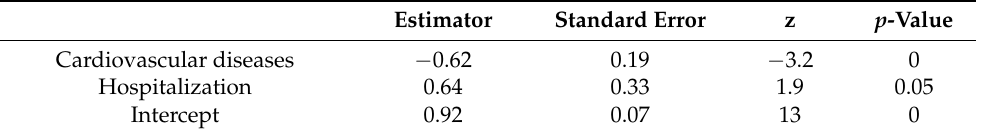
Table 3. Question five—logistic regression model; three or more responses indicating the satisfactory level of knowledge.